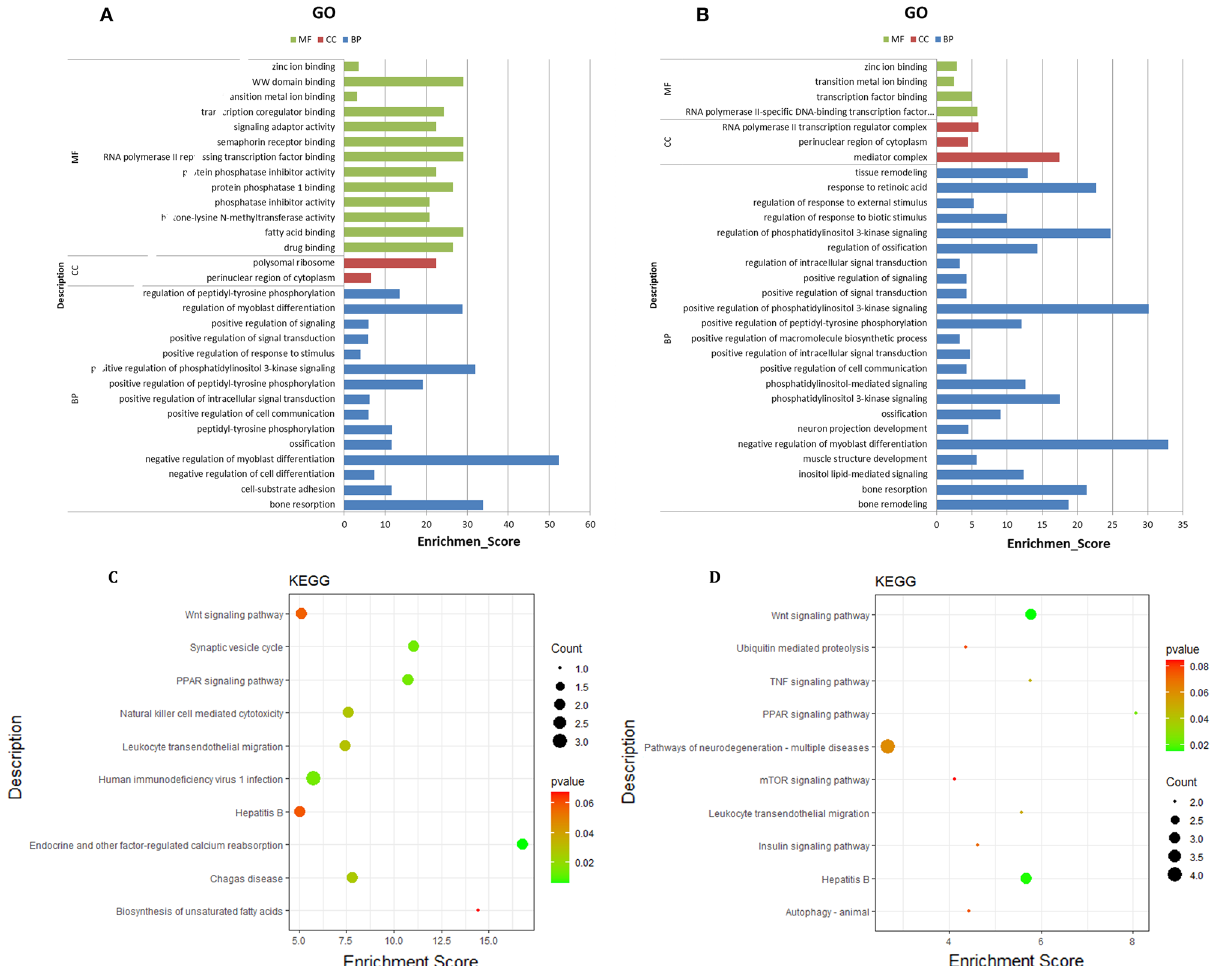
Figure 6. GO analysis of target genes of ( A ) circRNA_06424 and ( B ) circRNA_08840. KEGG parhway analysis of target genes of ( C ) circRNA_06424 and ( D )